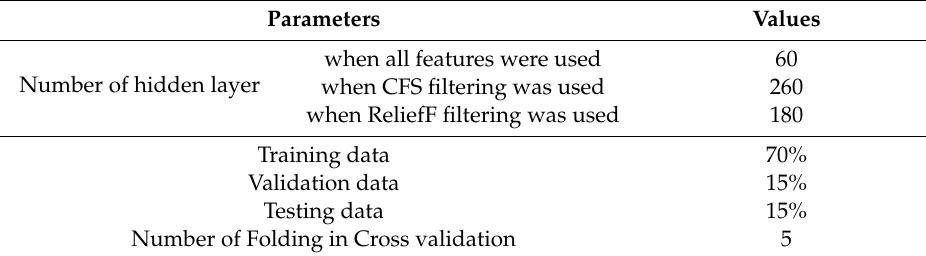
Table 3. Neural network parameters. CFS, correlation feature